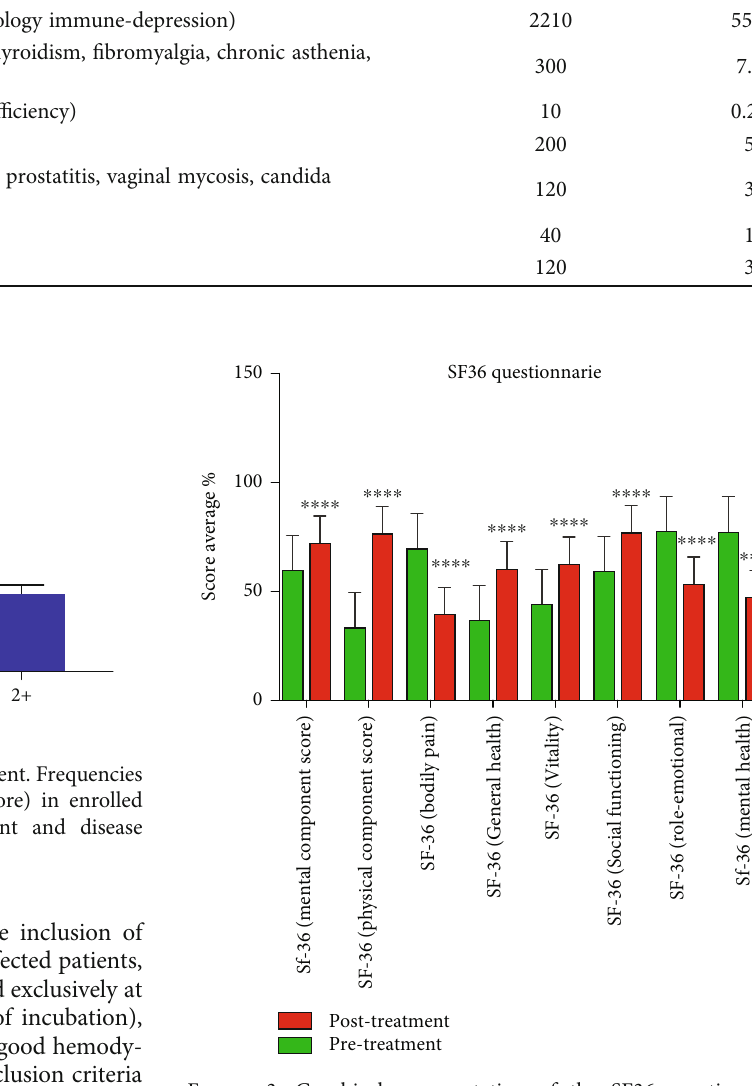
Figure 3: Graphical representation of the SF36 questionnaire results. Bar graphs showing the mean % SF-36 questionnaire results for the pretreatment (green graphs) and posttreatment (orange graphs) groups. The post-Parvulan injection scores were already statistically better than those collected pretreatment. Data are presented as the mean ± standard deviation (SD). There were signi fi cant di ff erences between pre- and posttreatment. ∗∗∗∗ p < 0 : 0001 , pre- vs. posttreatment.